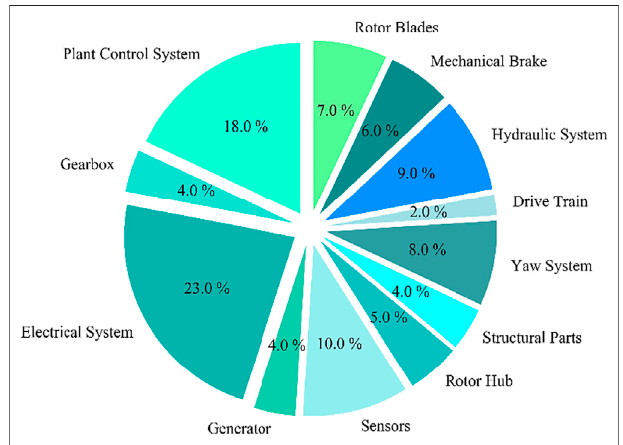
FIGURE 1 | Fault rate of wind turbine components (Hahn et al., 2007).